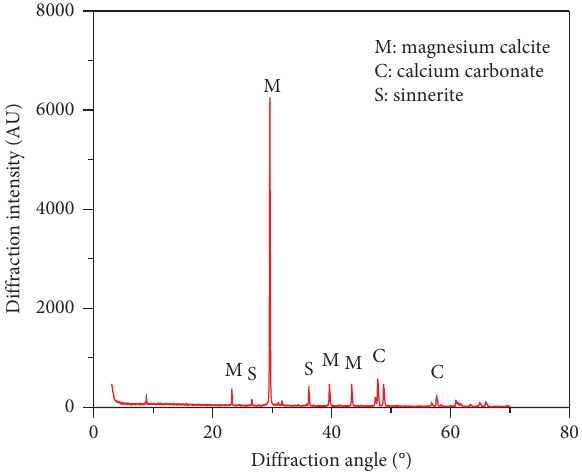
Figure 2: XRD result of tested